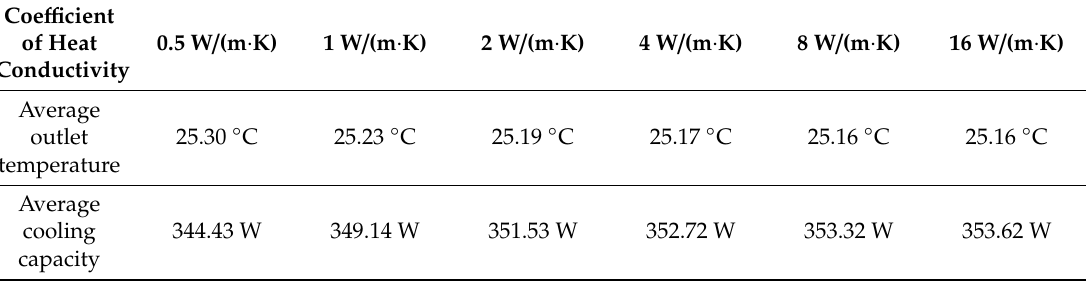
Figure 7. The effect of different tube conductivities on the outlet temperature and cooling capacity. Figure 7. The e ff ect of di ff erent tube conductivities on the outlet temperature and cooling capacity. Table 3. The average outlet temperatures and cooling